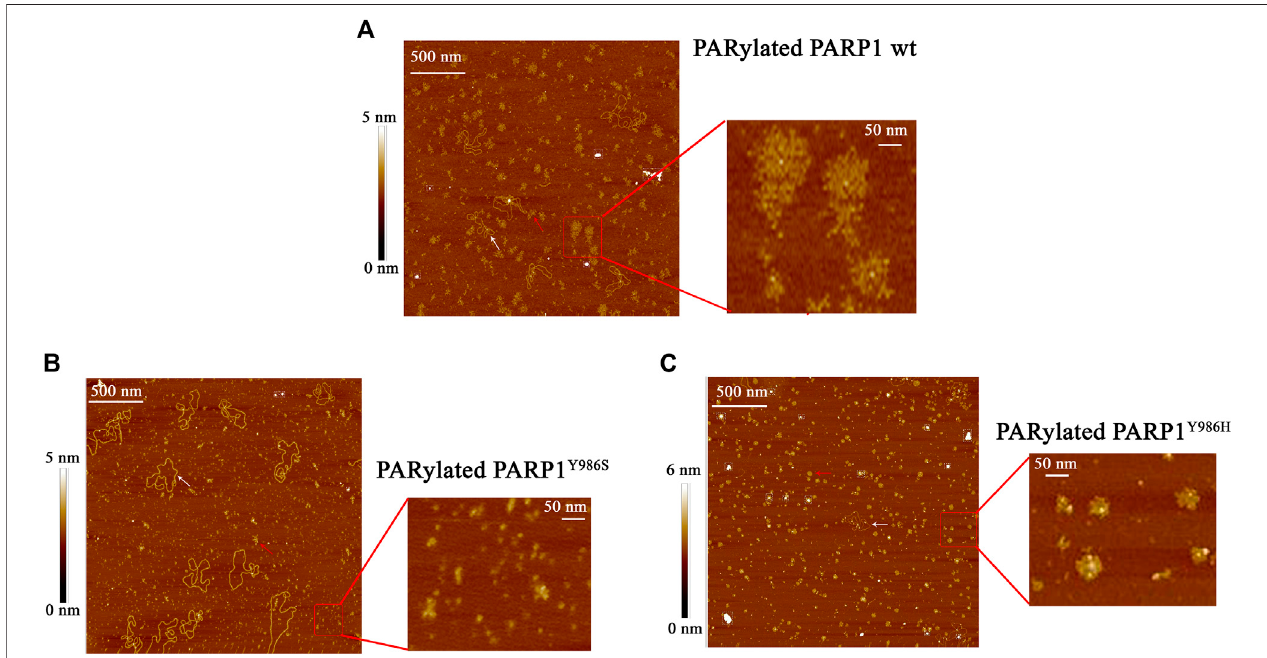
FIGURE 6 | AFM visualization of the shape of PAR polymers synthesized by PARP1 wt (A) or its mutants: PARP1 Y986H (B) or PARP1 Y986S (C) . The large scale of AFM images illustrate auto-PARylation of PARP1 and its mutants, red rectangle shows the higher magni fi cation image of modi fi ed molecules. White arrows indicate plasmid DNA molecules, and red arrows point to PARylated proteins. Scale bar: 500 nm; Z scale: 5 nm (for PARP1 wt and PARP1 Y986S ) and 6 nm (for PARP1 Y986H ).